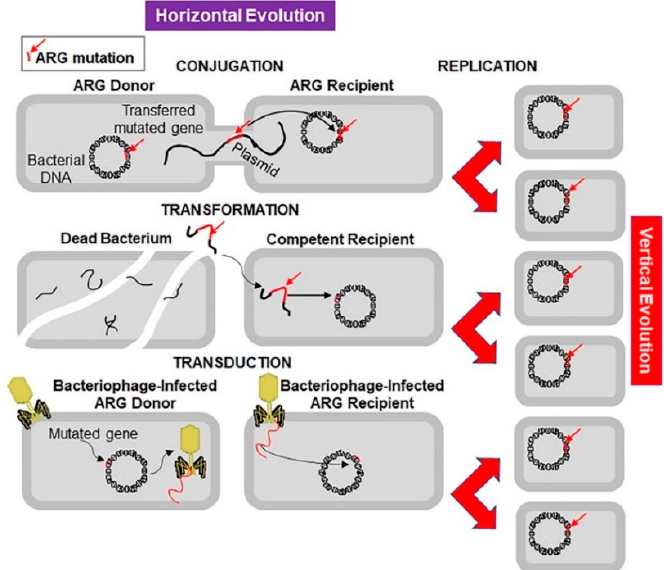
Figure 2. Mechanisms of horizontal and vertical transmission in bacteria for the development of antibiotic resistance. The left panel shows the horizontal transmission of an antibiotic resistant gene (ARG, red line indicated by a red arrow) by the three main mechanisms: conjugation, transformation, and transduction. Conjugation involves transfer of the ARG from a donor bacterium to a recipient by direct contact and plays a crucial role in dissemination of antibiotic resistance. Transformation involves uptake of the free DNA with the ARG from the environment. Transduction is a virus-mediated gene transfer by bacteriophages. The right panel shows the vertical evolution carried out by replication of bacteria containing the ARG.